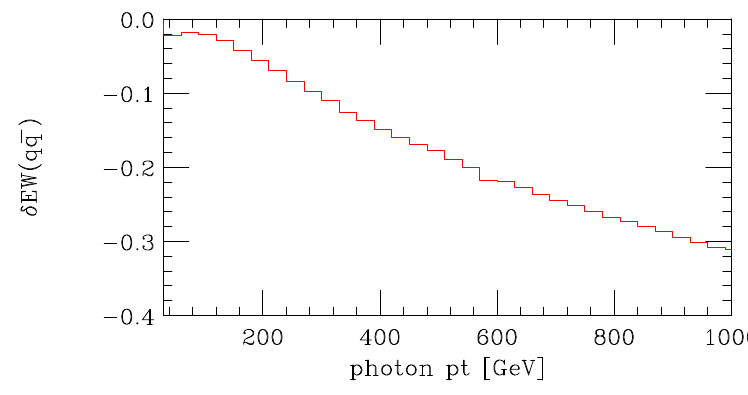
Figure 11 . Relative electroweak corrections to the q ¯ q -initiated process in eq.